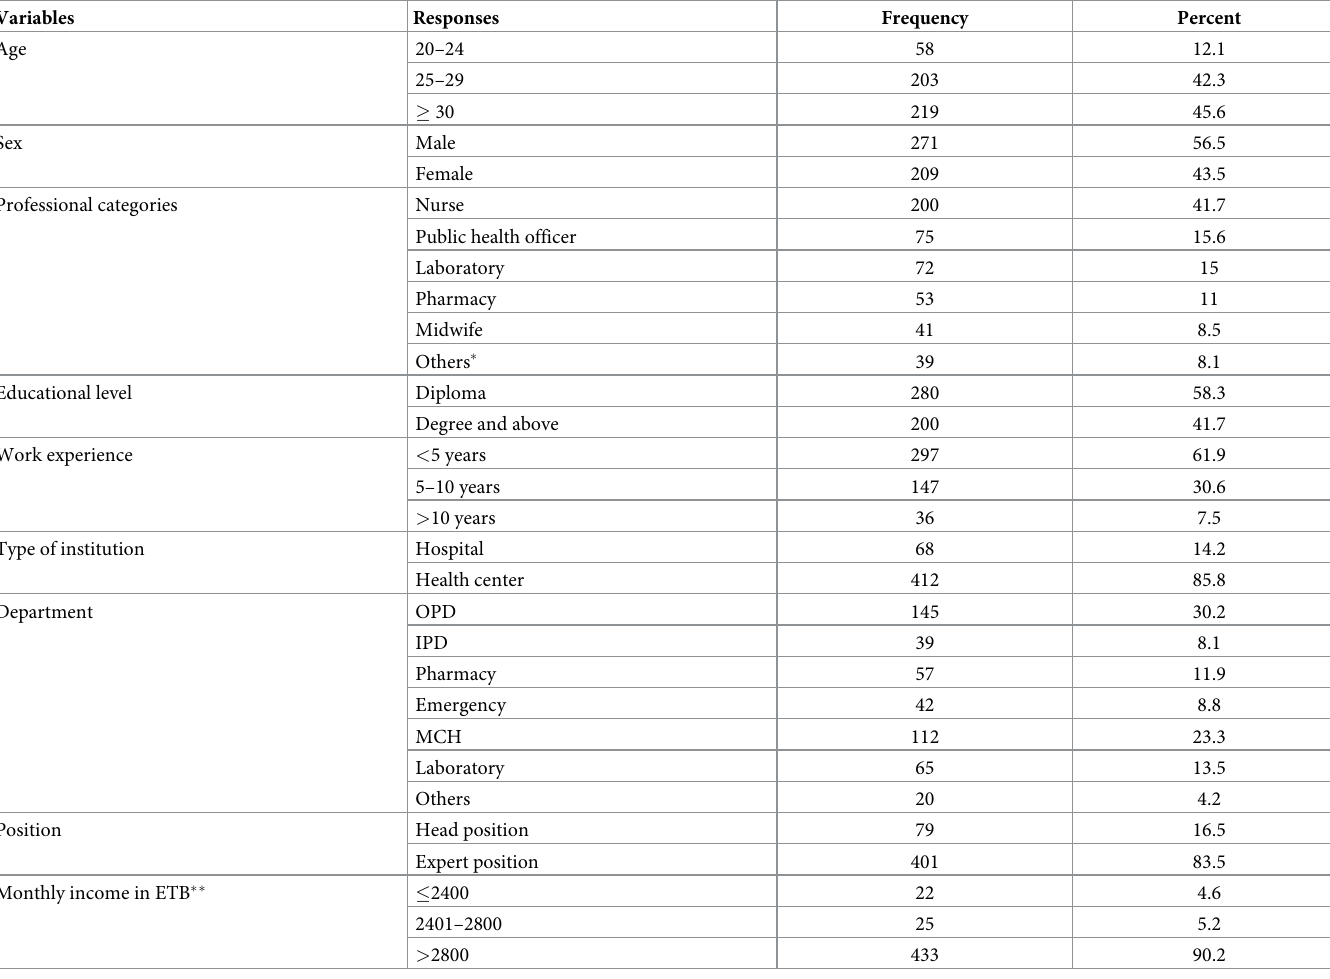
Table 1. Socio-demographic characteristics of health workers working at public health facilities in Hadiya zone, Ethiopia, 2019, (n =